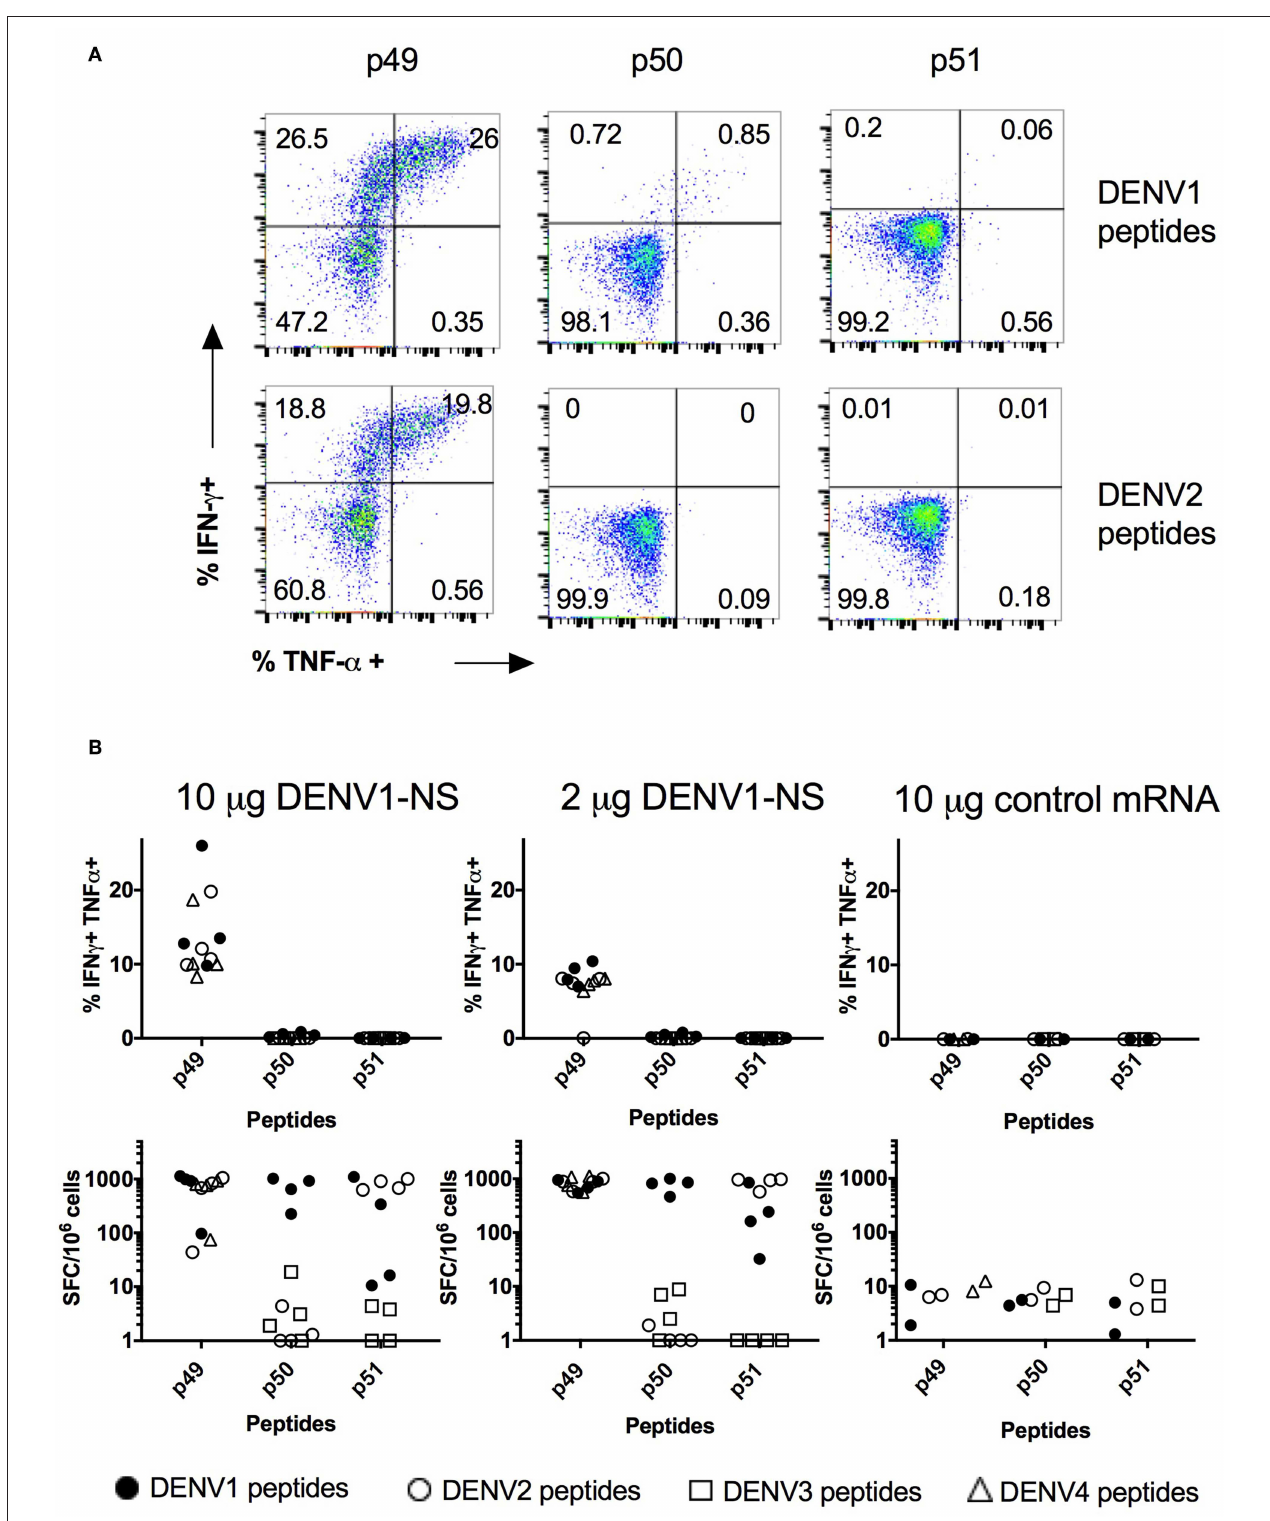
FIGURE 3 | Quantification of the T cell responses in HLA-B*3501 transgenic mice by intracellular cytokine staining and ELISpot assay. Two groups of 4 HLA-B*3501 transgenic mice received an intramuscular inoculation of 10 or 2 µ g of the LNP-based mRNA encoding DENV1-NS and 1 group of 2 HLA-B*3501 transgenic